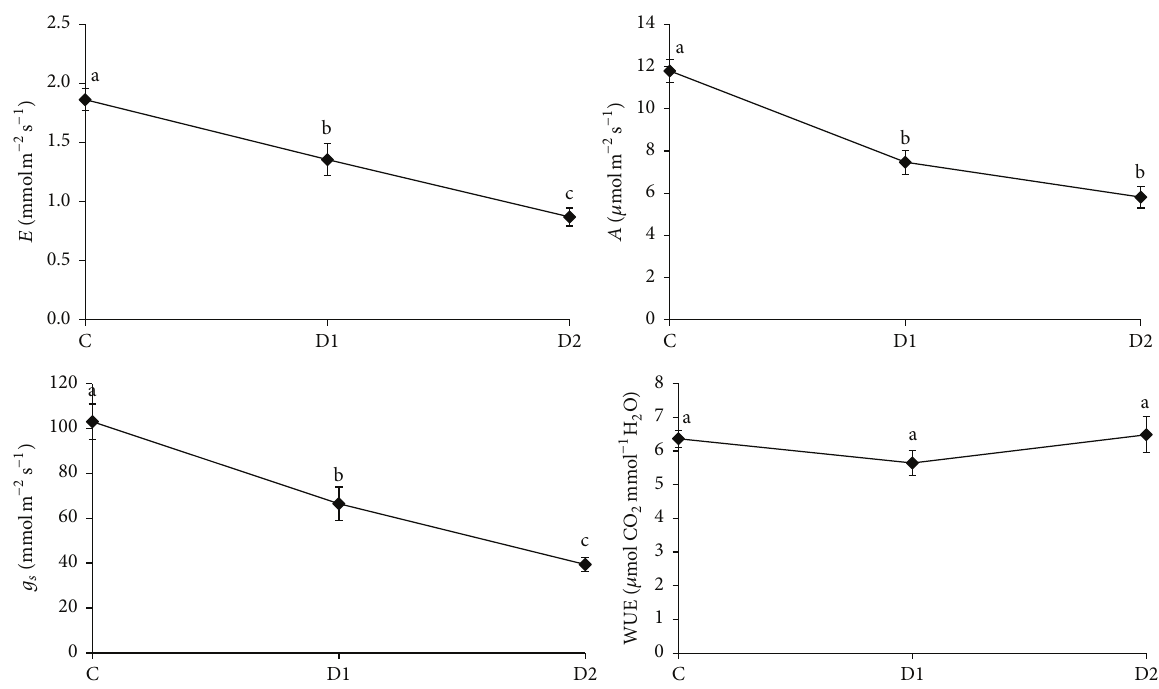
Figure 3: Effects of PEG levels (0, C; 2%, D1; and 4%, D2) on transpiration rate ( 𝐸 ), stomatal conductance ( 𝑔 𝑠 ), net photosynthesis ( 𝐴 ), and water use efficiency (WUE) of Thymus citriodorus. Values are mean ± SD of nine replicates.